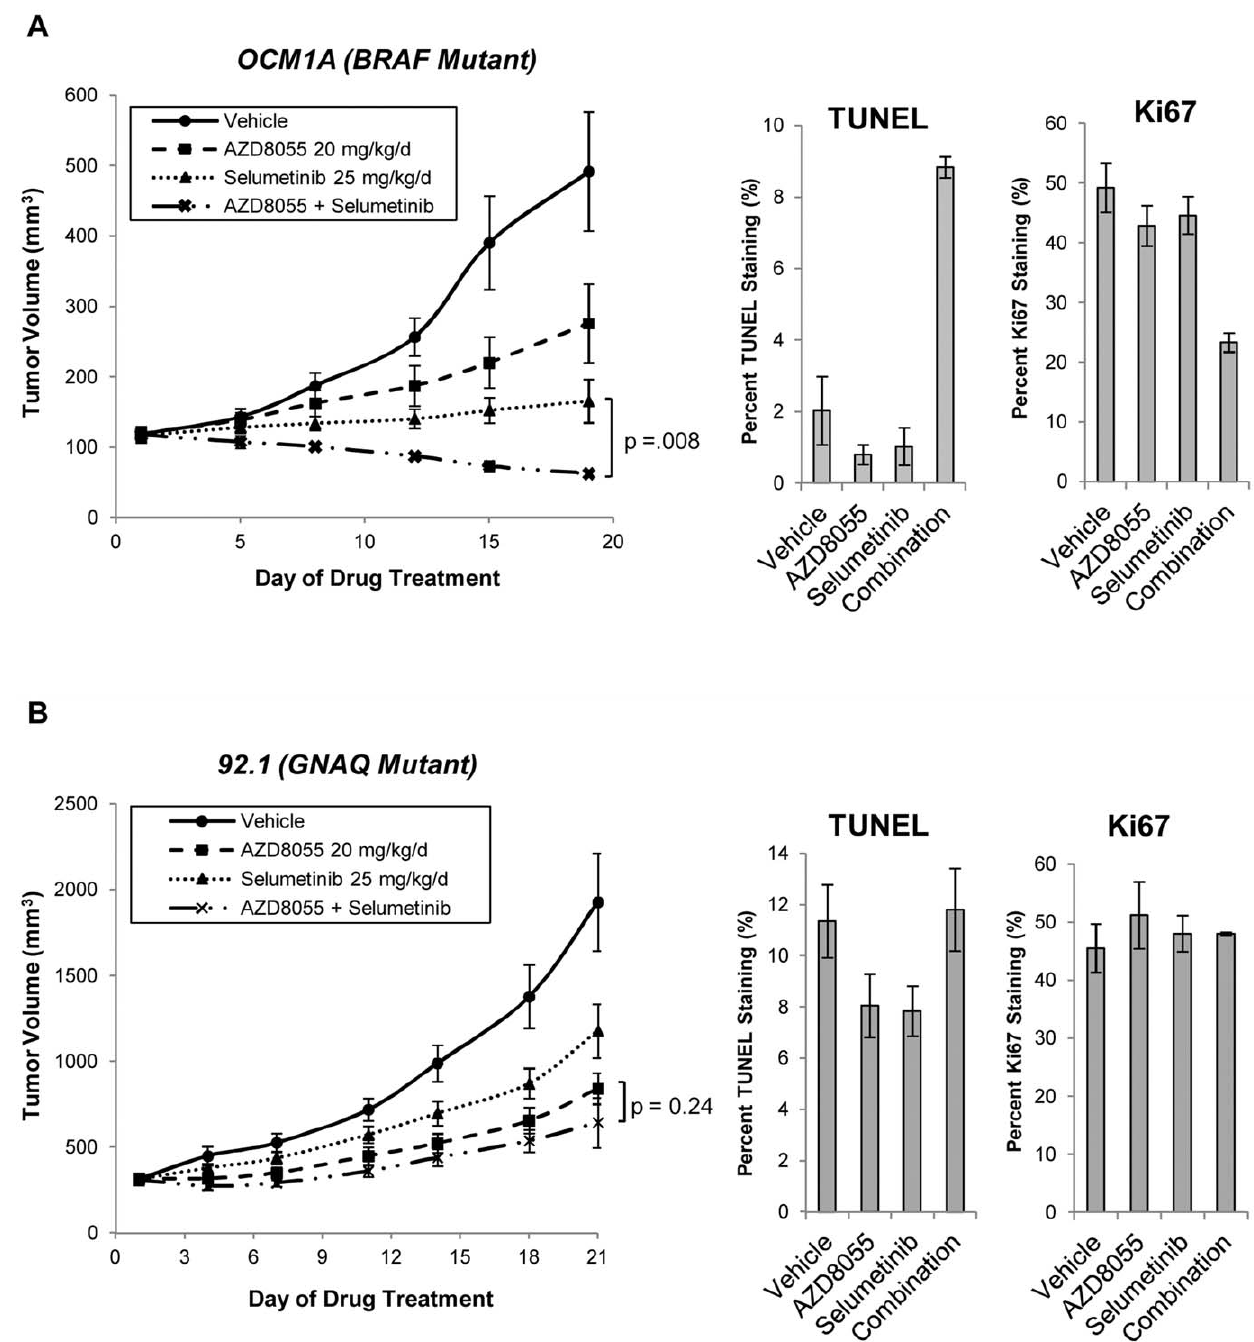
Figure 2. AZD8055/selumetinib induces tumor regression in a BRAF mutant, but not GNAQ mutant, xenograft model. A, AZD8055/ selumetinib cooperatively induced tumor regression relative to baseline in a xenograft model with the BRAF mutant OCM1A cell line. For detailed methods, please see the Materials and Methods section. Briefly, athymic mice were subcutaneously injected with OCM1A cells. Drug treatments began after the tumors were about 100 mm 3 . Animals with established tumors were treated once daily with AZD8055 (20 mg/kg/d) or selumetinib (25 mg/kg/d) alone or in combination for 5 days each week for a total of 3 weeks. Tumors were measured with calipers every 2 to 3 days. Tumor volume was compared between groups of mice at various points in time. Each value represents the mean measurement of 3 to 5 animals. p- value=.008 (Wilcoxon Rank Sum test) for the comparison of selumetinib alone versus the combination or AZD8055 alone versus the combination at Day 19. Also, after the fifth drug(s) or vehicle treatment, two animals from each cohort were sacrificed and the tumors were assessed for TUNEL and Ki67 staining. Results in the graphs represent the mean percentages from 4 randomly selected fields; at least 100 cells were counted from each field. B, AZD8055/selumetinib failed to induce tumor regressions in the GNAQ mutant 92.1 cell line xenograft model. The experiment was conducted as described in A . p-value=0.24 (Wilcoxon Rank Sum test) for the comparison of AZD8055 alone versus the combination. Error bars, SE .